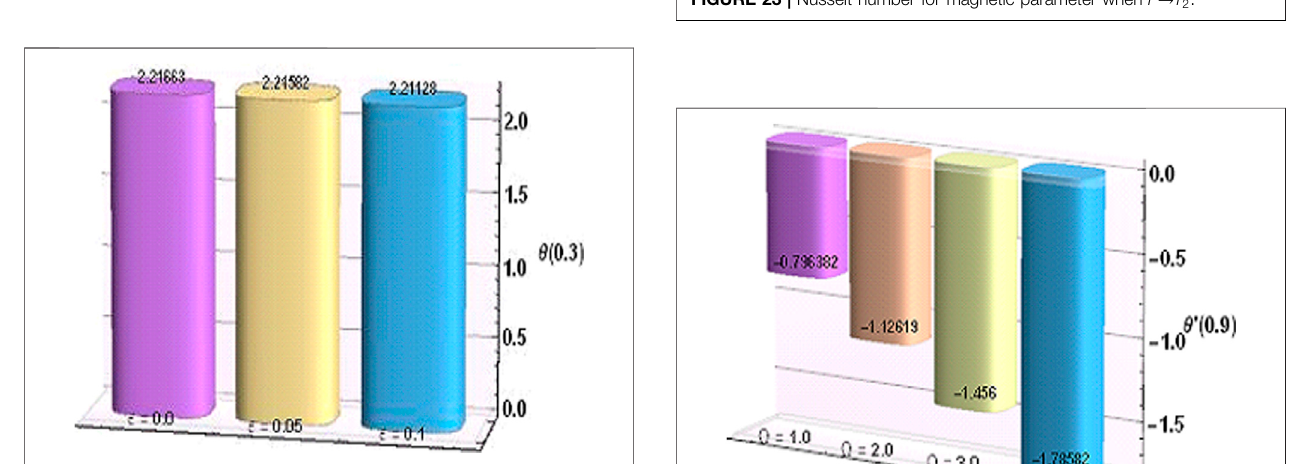
FIGURE 23 | Nusselt number for magnetic parameter when r → r 2 .